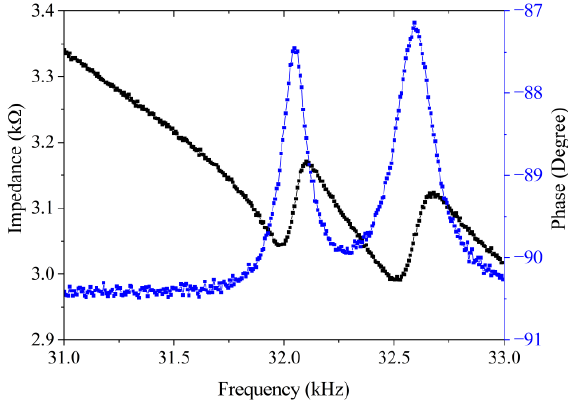
Figure 9. Frequency response characteristics of impedance and phase for the traveling wave vibrator measured using an impedance analyzer. Table 4. Comparison of the resonant frequencies of the two modes obtained by simulation and experiment.